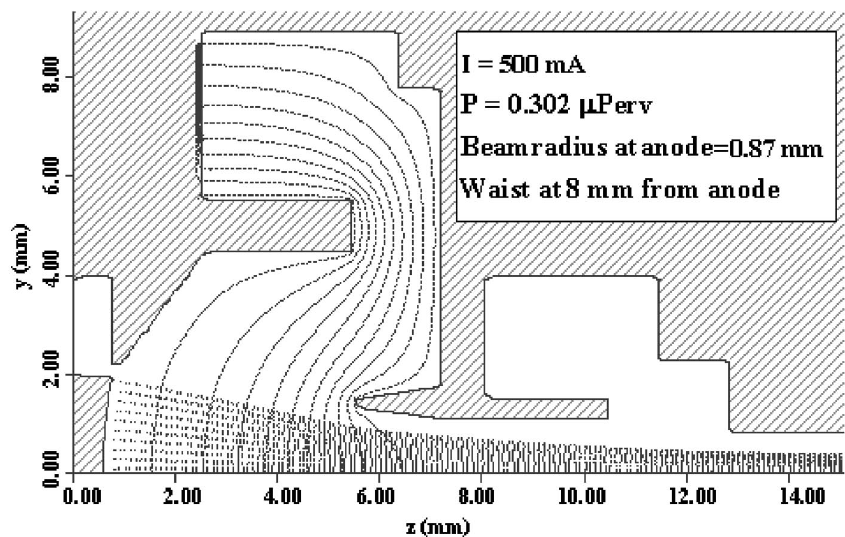
FIG. 4. Cathode simulated by EGUN